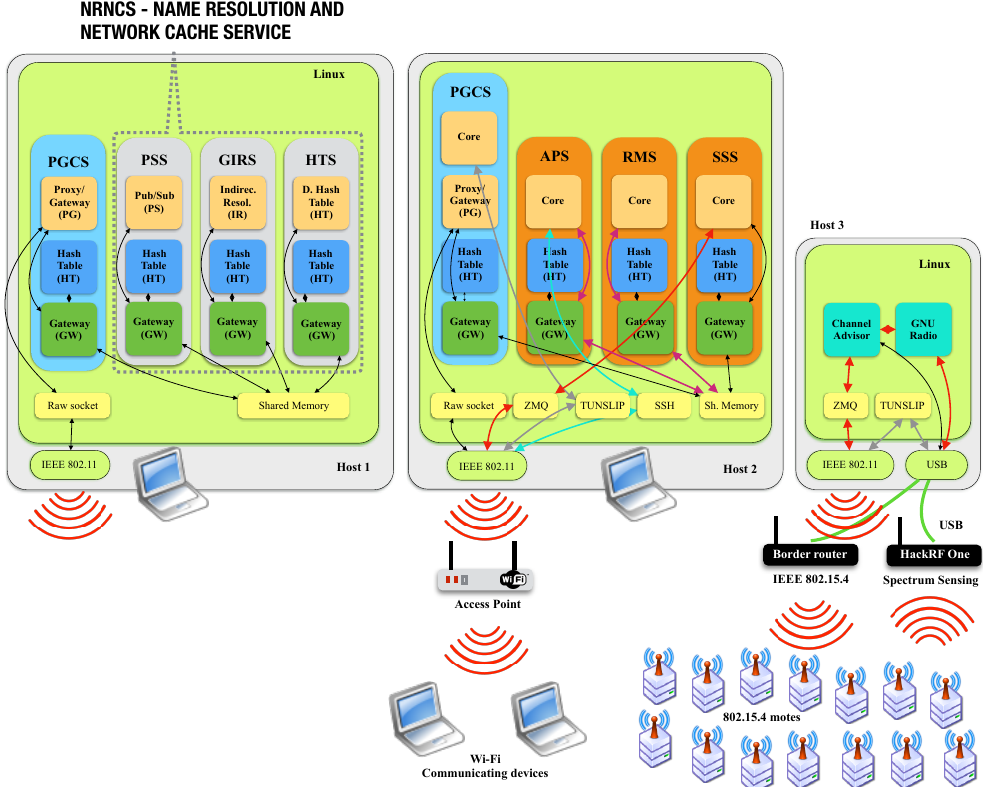
Figure 7. Joint IoT and Wi-Fi spectrum management with NovaGenesis. The Host 1 is running NG core services, while Host 2 is running NG spectrum management services, including spectrum sensing service (SSS), access point service (APS) and resource management service (RMS). SSS provides best channel indications to RMS based on HackRF One TM measures. RMS manages channel indications and selects best channels for Wi-Fi and IEEE 802.15.4 devices. APS configures the best channel to be used in Wi-Fi access points. Observe that PGCS at Host 2 has a core block, which implements service offering and acceptance from RMS. Host 3 is running Channel Advisor (CA) and GNU